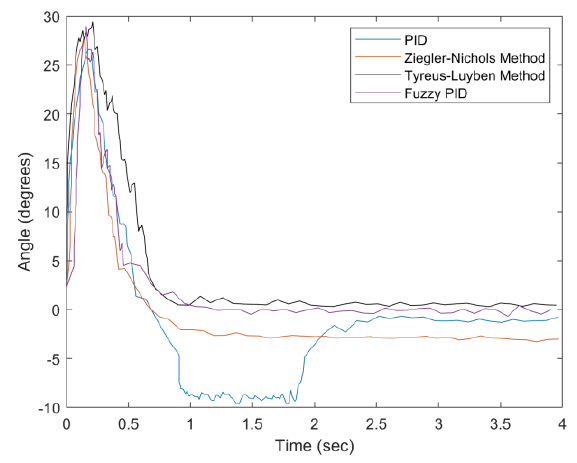
Figure 33. Convergence of angle with weight = 200 g. Table 7. Comparison of Experiment I. PU: percentage undershoot, ST: settling time.